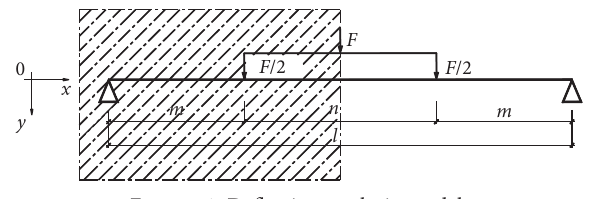
Figure 4: Deflection analysis model.